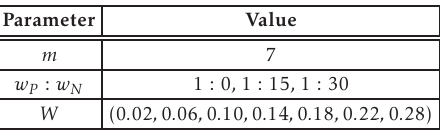
Table 3. The Properties of Networks in the Simulation Network